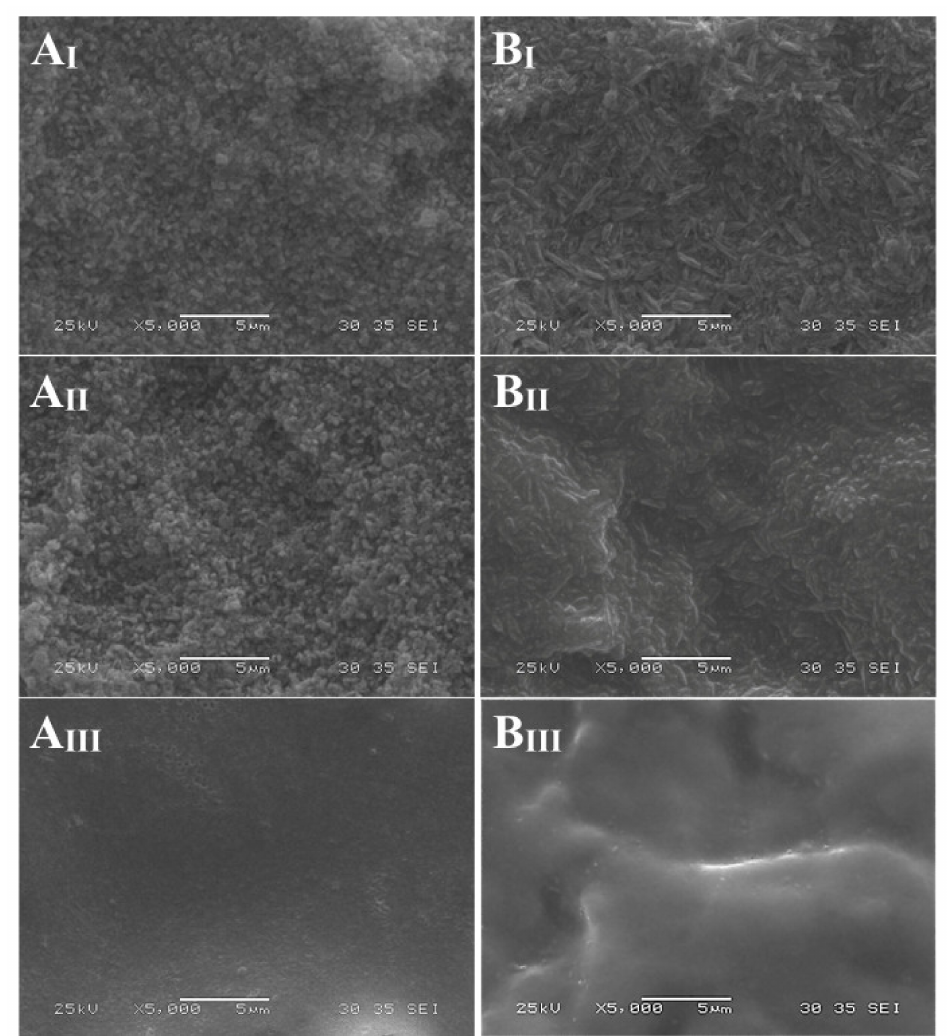
Figure 1. VITA Suprinity ( A ) and IPS e.max CAD ( B ) after conditioning with hydrofluoric acid ( I ), hydrofluoric acid and silane ( II ), Monobond Etch & Prime ( III ). SEM images at 5000 ×